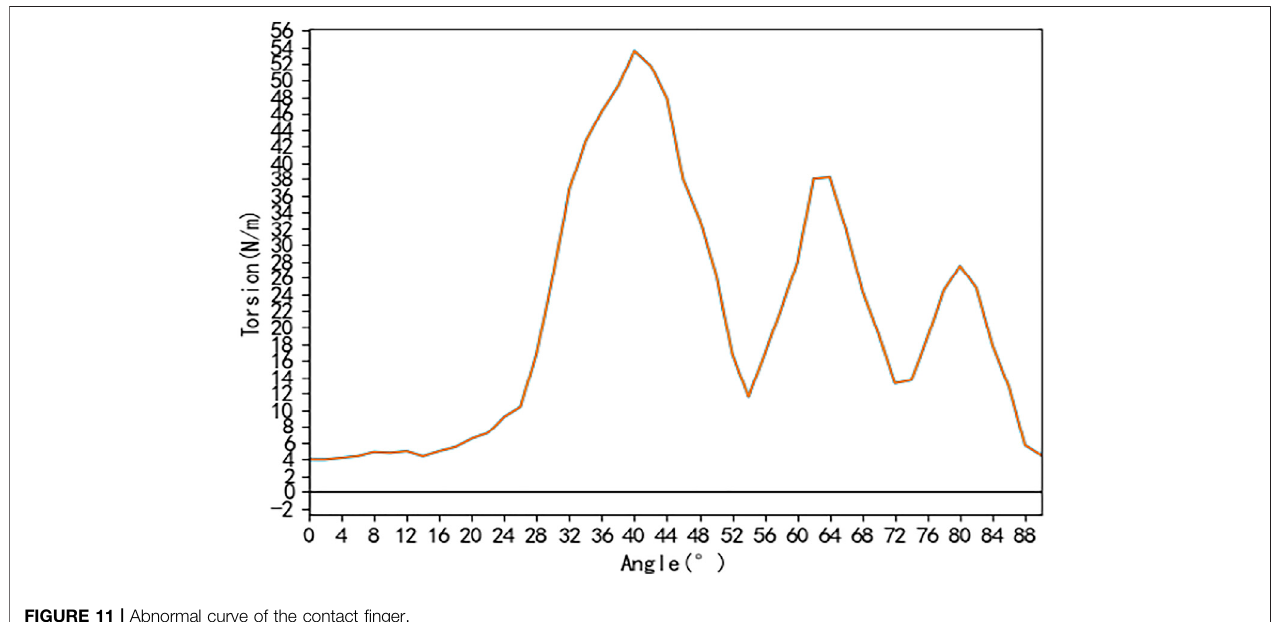
FIGURE 11 | Abnormal curve of the contact fi nger.